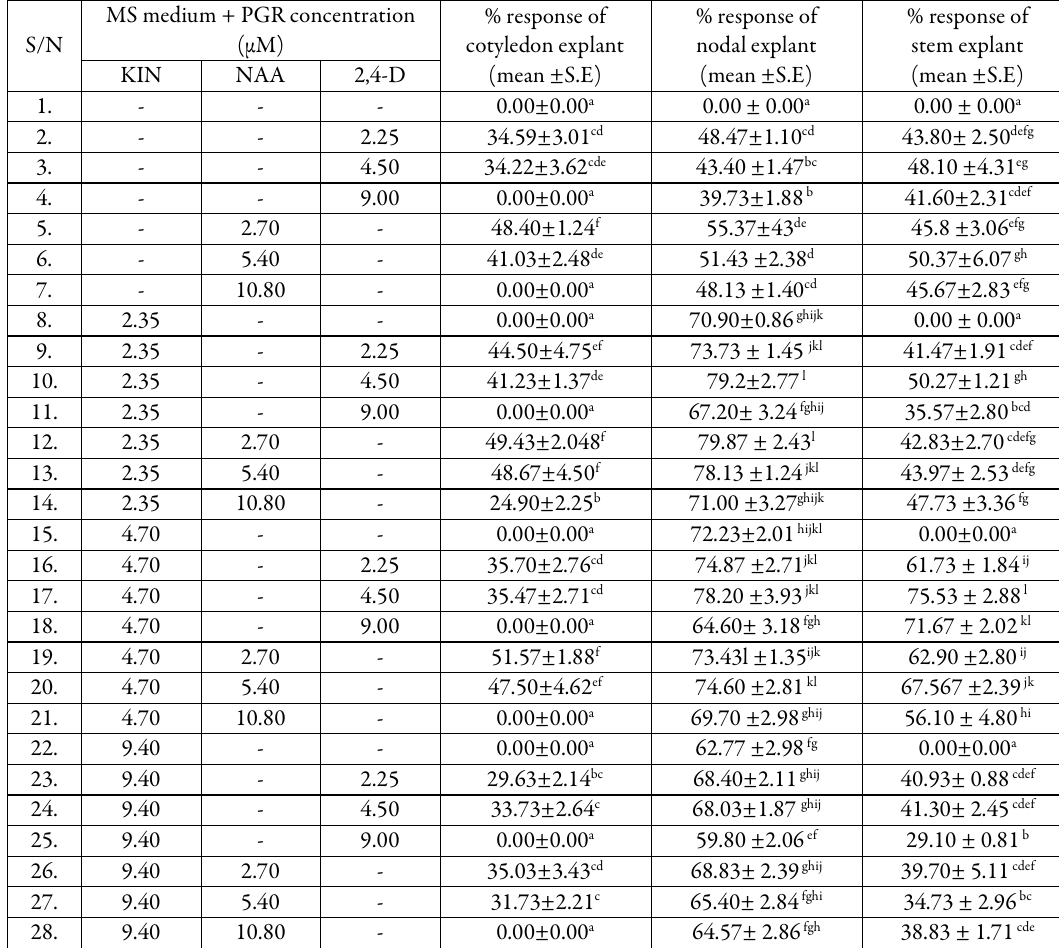
PGR: Plant growth regulators; BA:Benzyl Adenine; NAA:Naphthaleneacetic Acid; 2, 4-D:2, 4- Table 2. The effects of various concentrations of NAA, 2, 4-D alone or each separately combined with kinetin on callus/shoot induction from cotyledon, stem and nodal explants of E. cyclocarpum